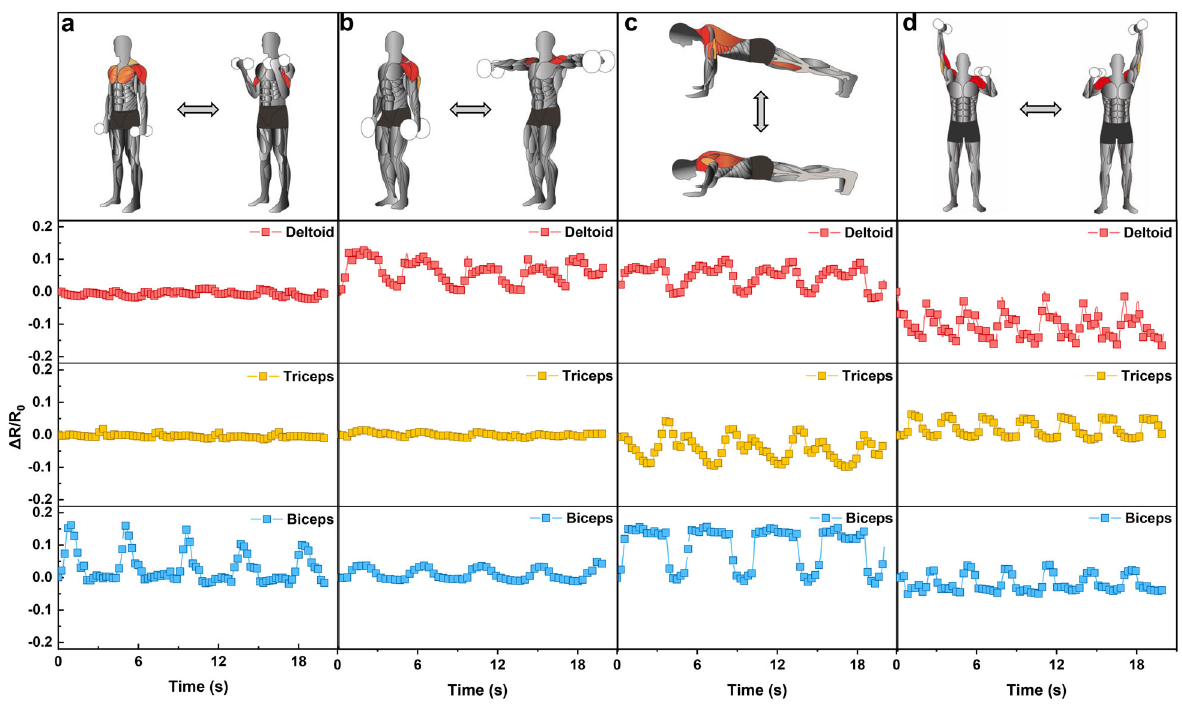
Fig. 5 Subtle motion monitoring by three channels. Three H-junction bending sensors reverse horizontally attached to epidermis corresponding to the biceps, triceps and deltoid muscle at the same time, respectively. Responses in resistance during the fi tness exercise of a standing dumbbell curls, b side lateral raise, c push-ups, and d shoulder press,